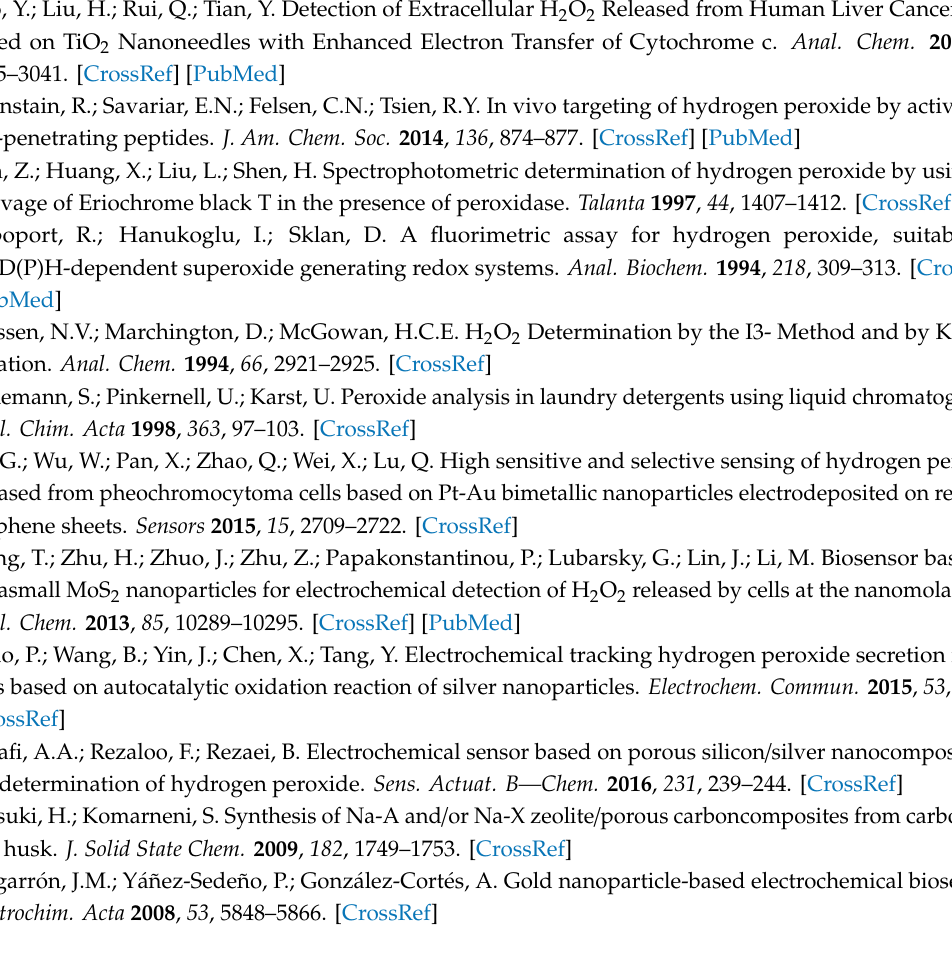
Figure S1: current–potential curves of the Ag-mSiO 2 NPs / GCE for electrocatalytic reduction of H 2 O 2 at the scan rate of 50 mV s − 1 in 0.2 M PBS solution with di ff erent modifiers of Ag-mSiO 2 ; Figure S2: The amperometric response of Ag-mSiO 2 nanoparticles / glass carbon electrode (NPs / GCE) (with applied potentials of − 0.40, − 0.45, − 0.50, and − 0.55 V) in PBS solution (0.2 M, pH 6.8) upon successive additions of 1.0 mM H